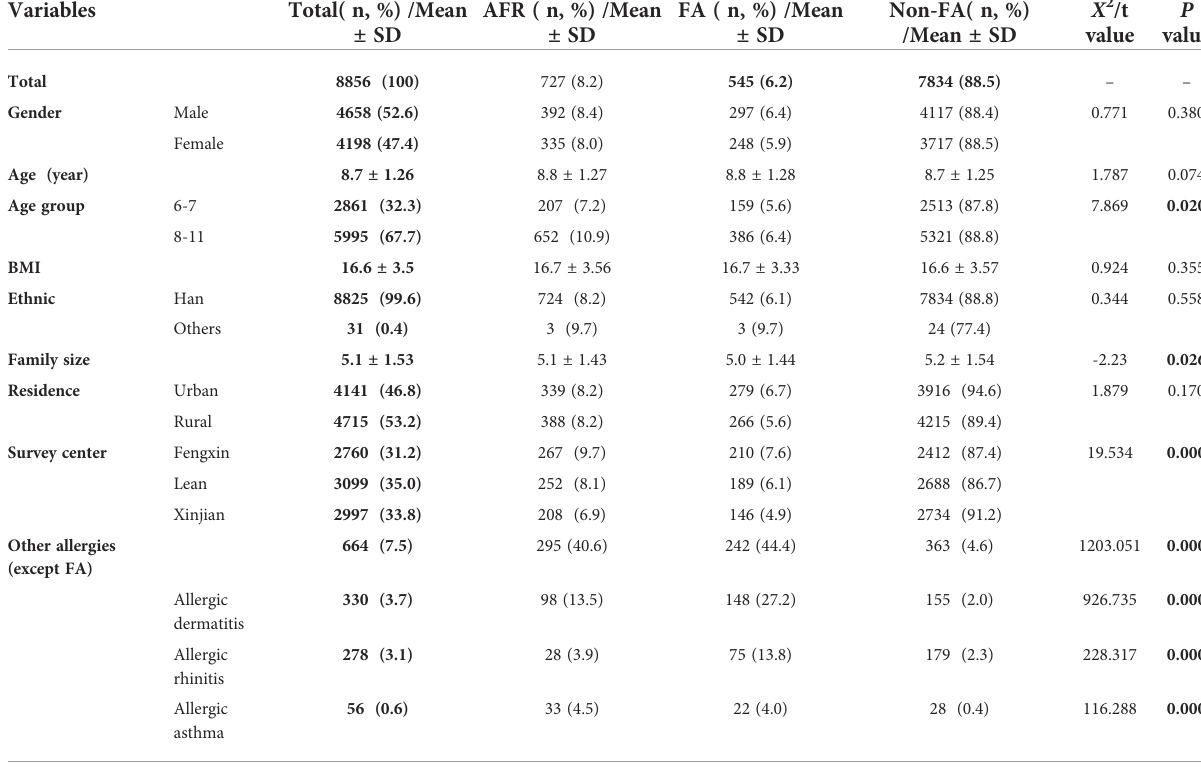
TABLE 1 Demographic characteristics and prevalence of reported ARF and